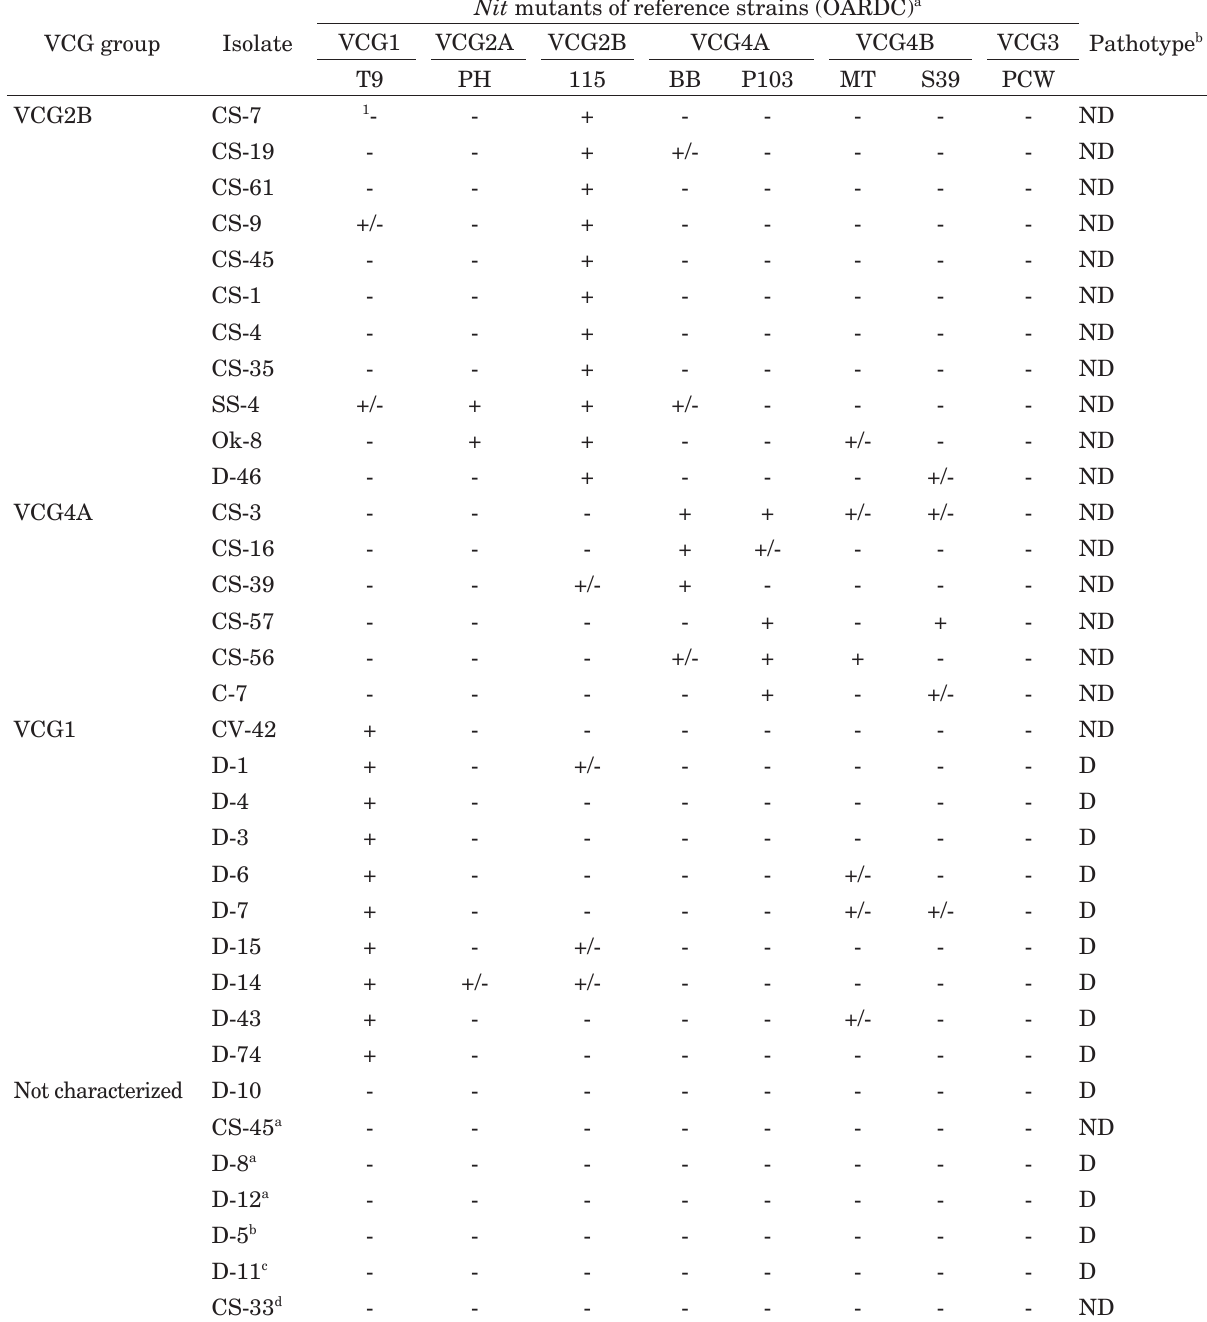
Table 4. Vegetative compatibility groups (VCGs) of Verticillium dahliae isolates from cotton using international tester